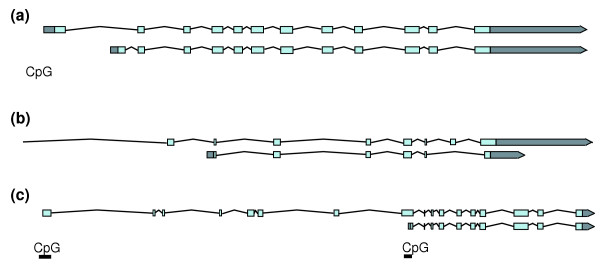
Three types of alternative transcription starts identified in this study. (a) ME-Exon: mutually exclusive starting exons (Sgk; GenBank:AK132234 and GenBank:AK086892). (b) Intronic: starts within introns that run into the next exon (Egfr; GenBank:AF275367 [longer form] and GenBank:AK087861 [shorter intronic start form]). (c) Exonic: starts within exon of longer transcript (Ntrk1; GenBank:AK081588 and GenBank:AK148691; supported by a CpG island and 5'-RACE). 5'-RACE, 5' rapid amplification of cDNA ends.